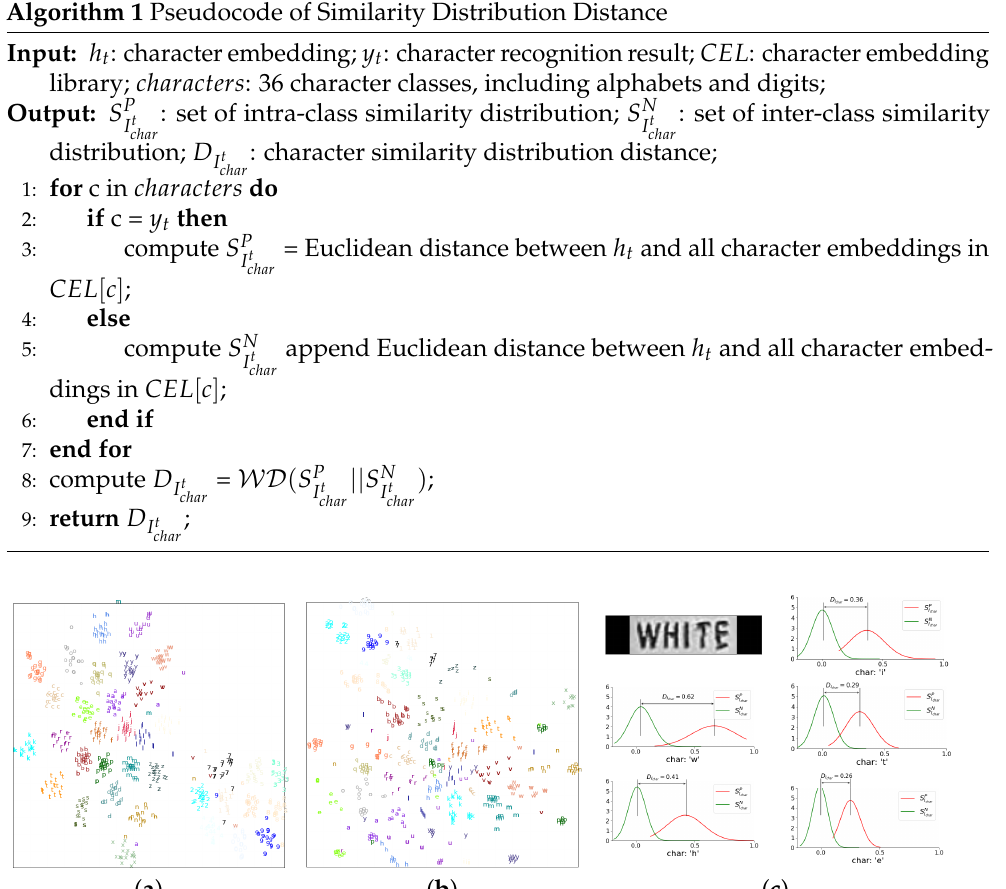
Algorithm 1 Pseudocode of Similarity Distribution Distance